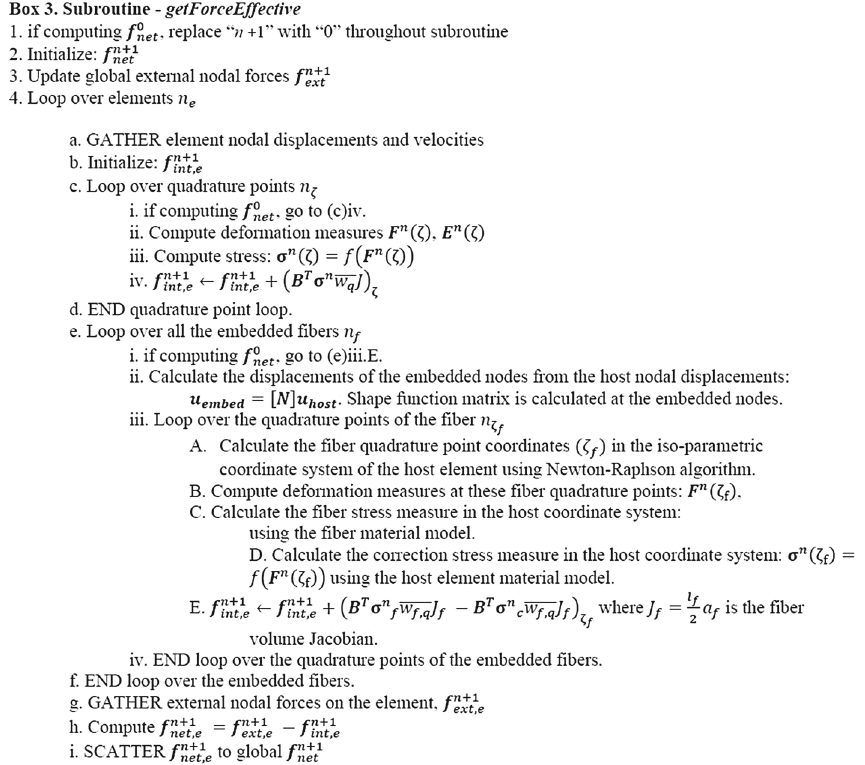
Fig. 8 Algorithm suggested by Garimella [20] to address internal energy redundancy